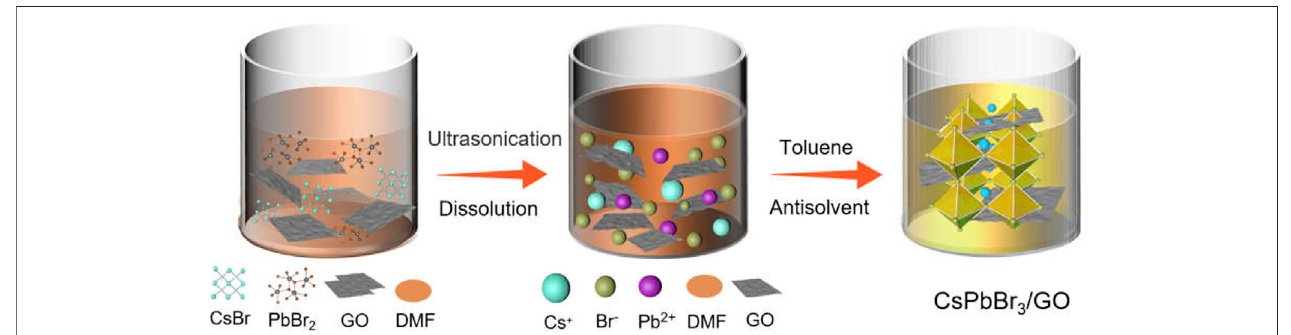
SCHEME 1 | Schematic diagram for the fabrication of CsPbBr 3 /GO